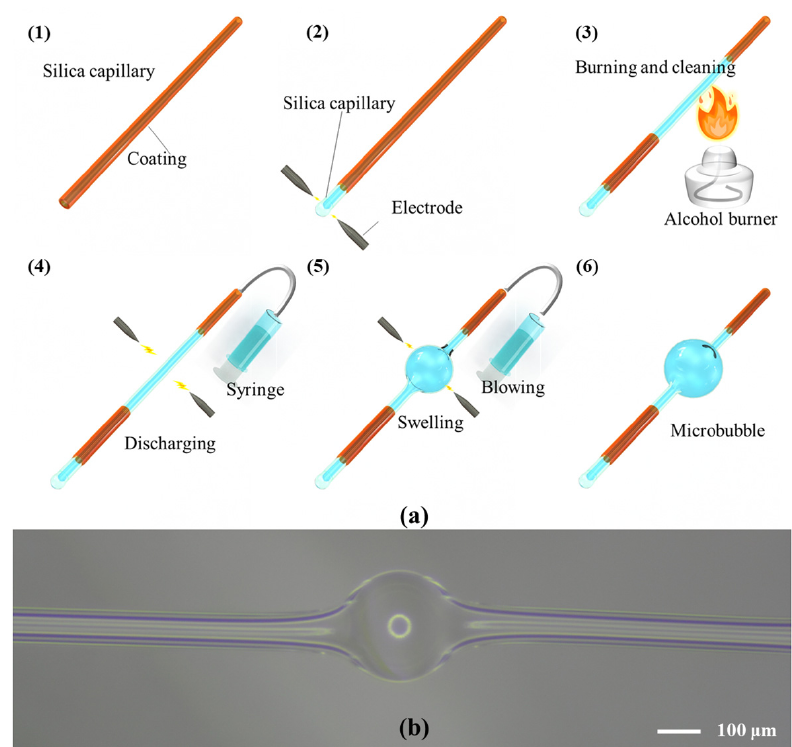
Figure 5. Fabrication of the microbubble resonators: ( a ) process for fabrication a microbubble resonator by the electrode discharge heating. (1) Silica microcapillary; (2) sealing one end of the silica microcapillary; (3) burning and cleaning the polymer coating; (4–6) fuse-and-blow process for microbubble fabrication; ( b ) optical microscopy image of a microbubble resonator.